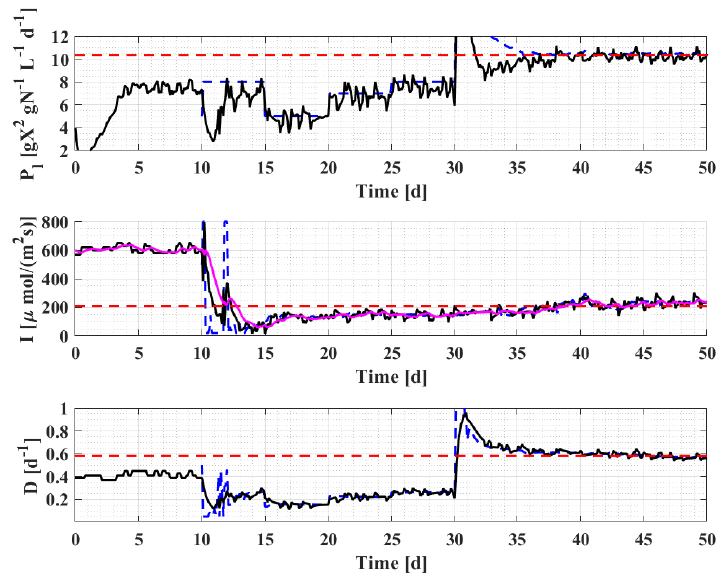
Figure 4. Time evolution of productivity P l , incident light I , and dilution rate D following SOP and ESC (red: optimal values; blue: estimated references; black: trajectory; magenta: ¯ I )